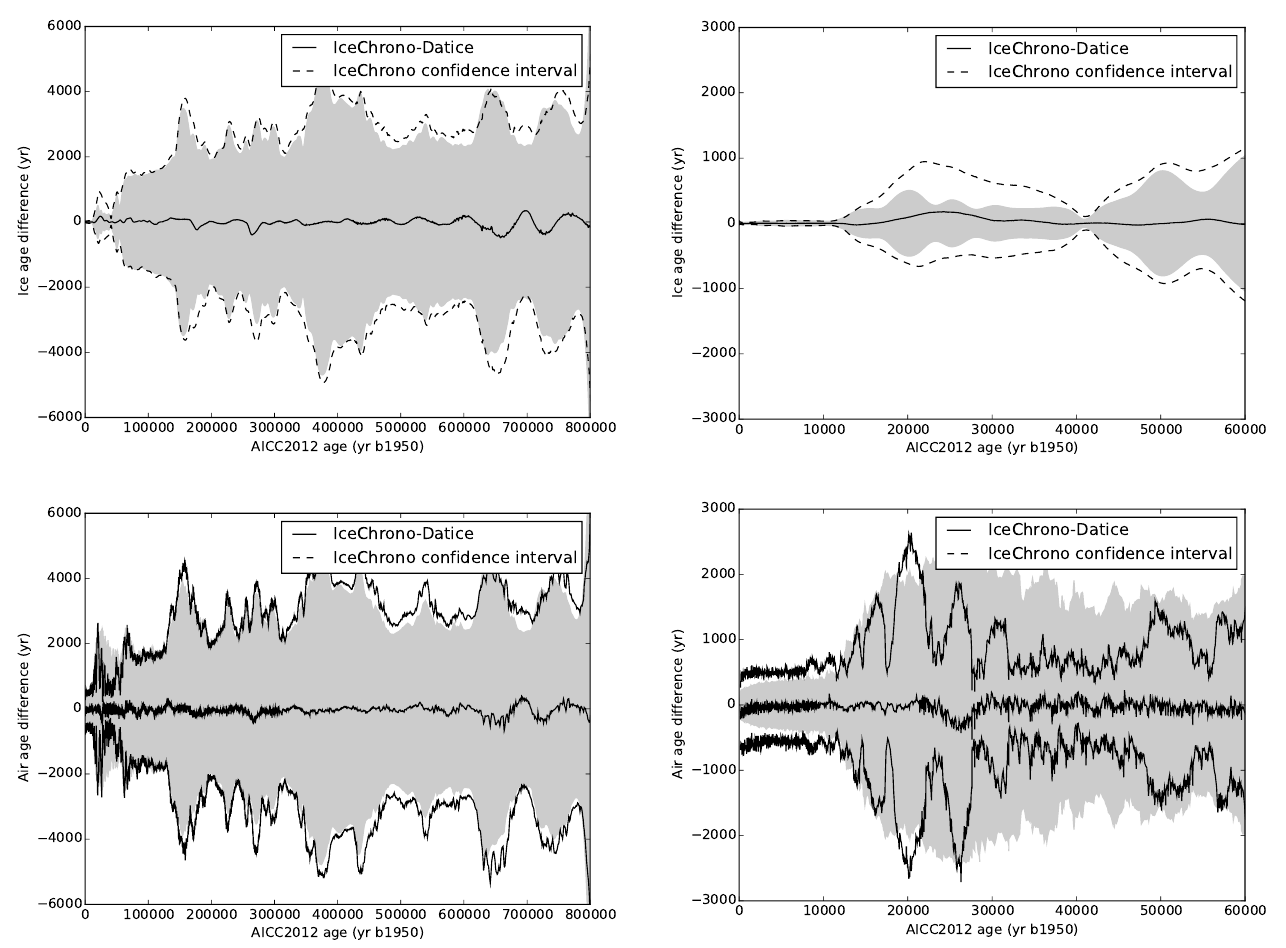
Figure 4. Comparison of IceChrono and Datice chronologies of the EDC ice core in the AICC2012 experiment. IceChrono is the black plain line and its standard deviation is the black dashed line. The AICC2012 standard deviation is represented by the grey area. (top) Ice chronologies. (bottom) Air chronologies.